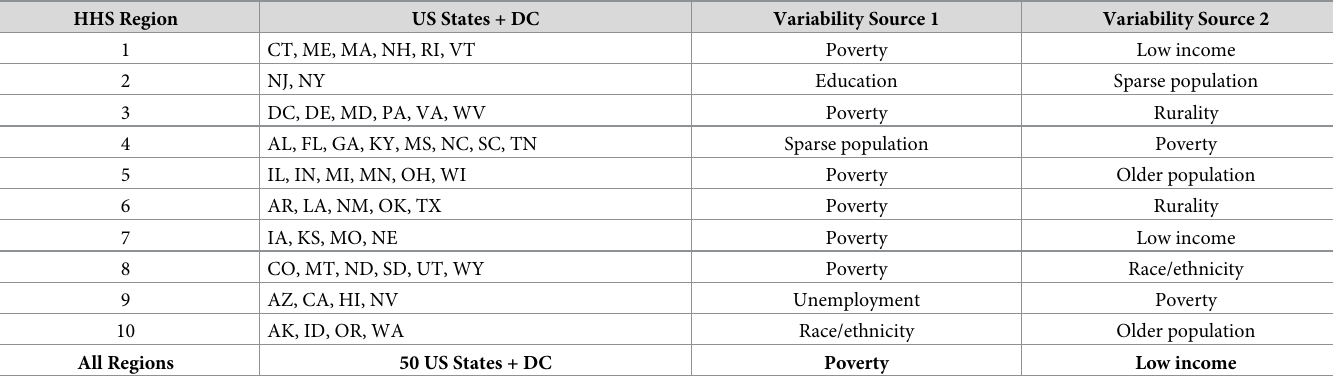
Table 4. Markers with greatest variability in pcHPSA counties, by HHS Region,